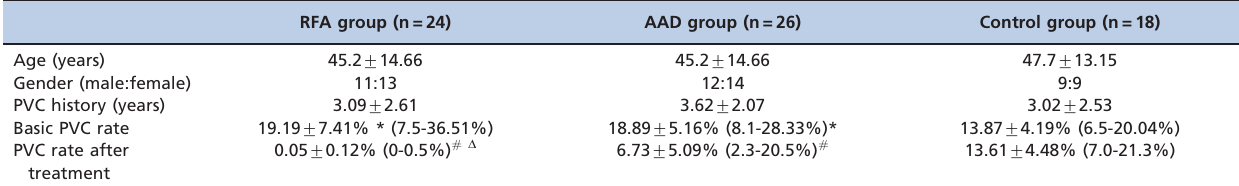
Table 1 - General characteristics of each